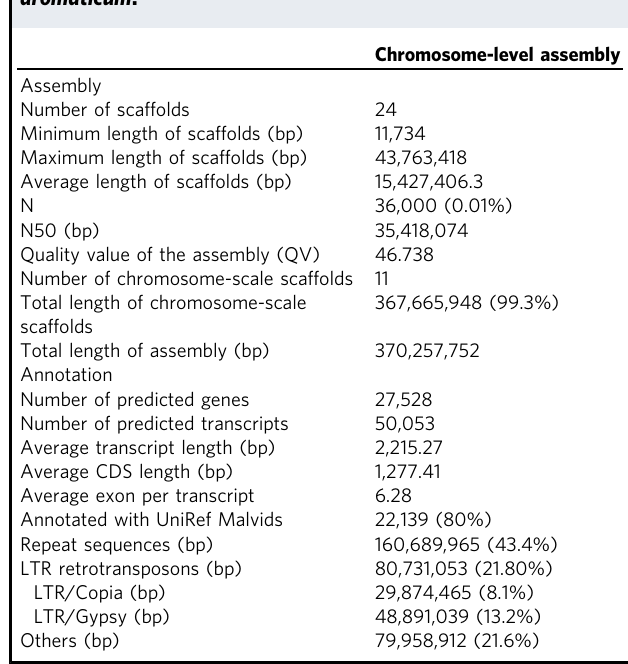
Table 1 The statistics for genome assembly of